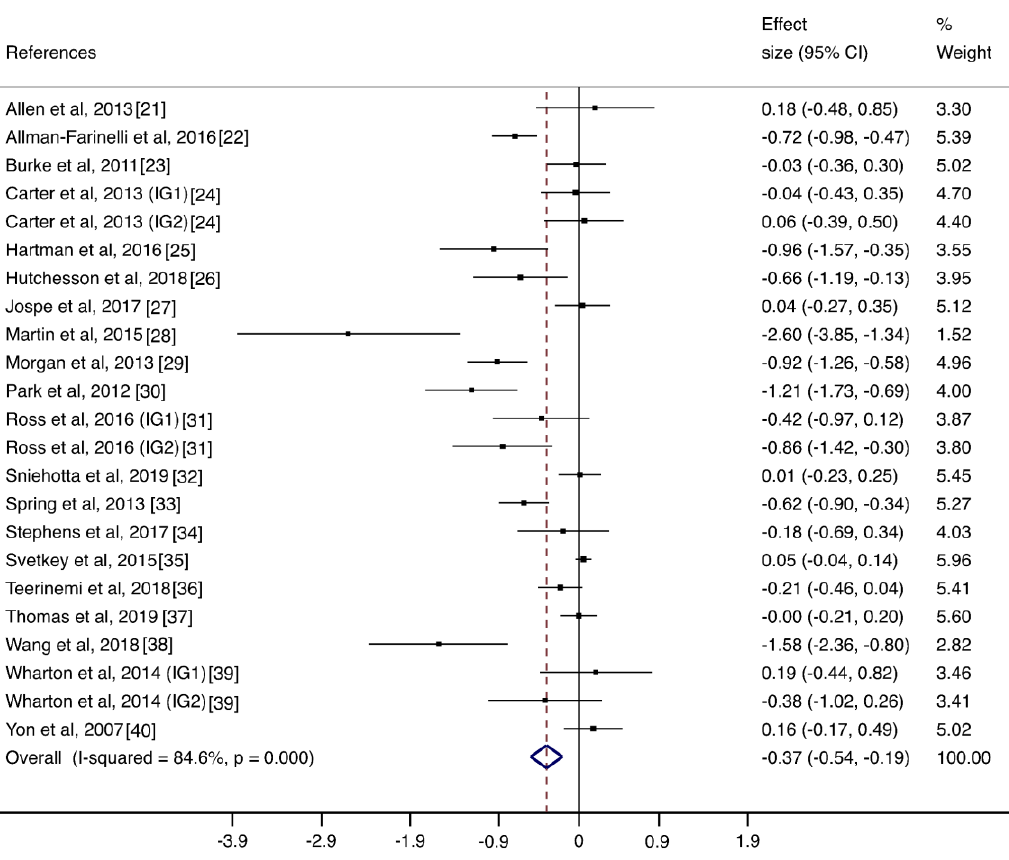
Figure 2. Forest plots of the pooled effect size for behavioral weight management interventions using lifestyle mHealth self-monitoring on weight loss.